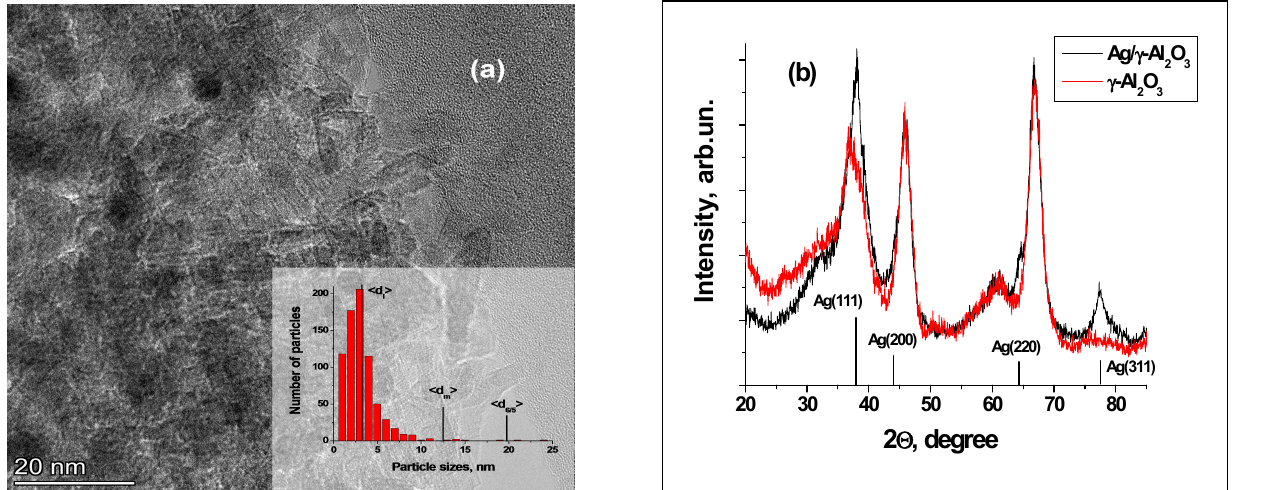
Figure 1. ( a ) TEM photo for Ag/ γ -Al 2 O 3 sample with Ag particle size distribution. ( b ) XRD patterns for Ag/ γ -Al 2 O 3 (black line) and γ -Al 2 O 3 (red line) samples. The vertical black lines indicate Ag reflexes (JCPDS 04-0783).